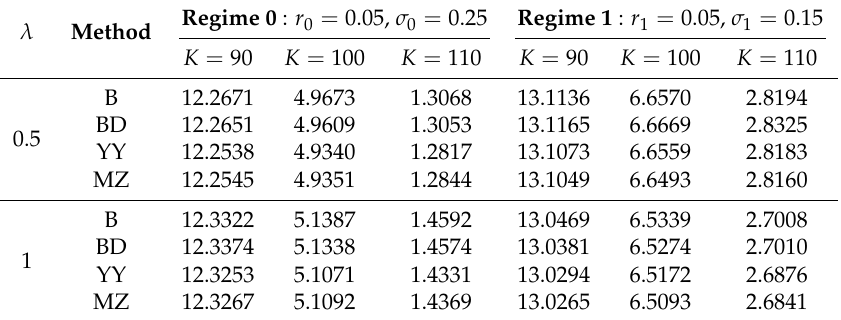
Table 2. European Asian call option prices in a two-regime economy with a 0,1 = a 1,0 = λ (1/year). λ